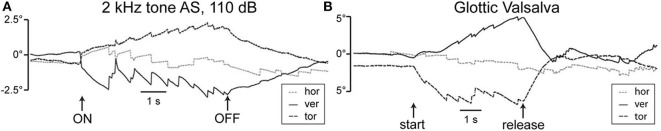
Eye positions recorded from a patient with SSCD. (A) Sound-evoked eye movements with 2 kHz tone at 110 dB presented to the left dehiscent ear. Slow phase components are directed upward and clockwise with respect to the patient's point of view, consistent with excitation of the left superior semicircular canal. (B) Pressure-evoked eye movements with glottic Valsalva. Slow phase components are principally downward and counterclockwise consistent with inhibition of the left superior semicircular canal. Release causes reversal of the evoked eye movements. Republished from (22), with permission.